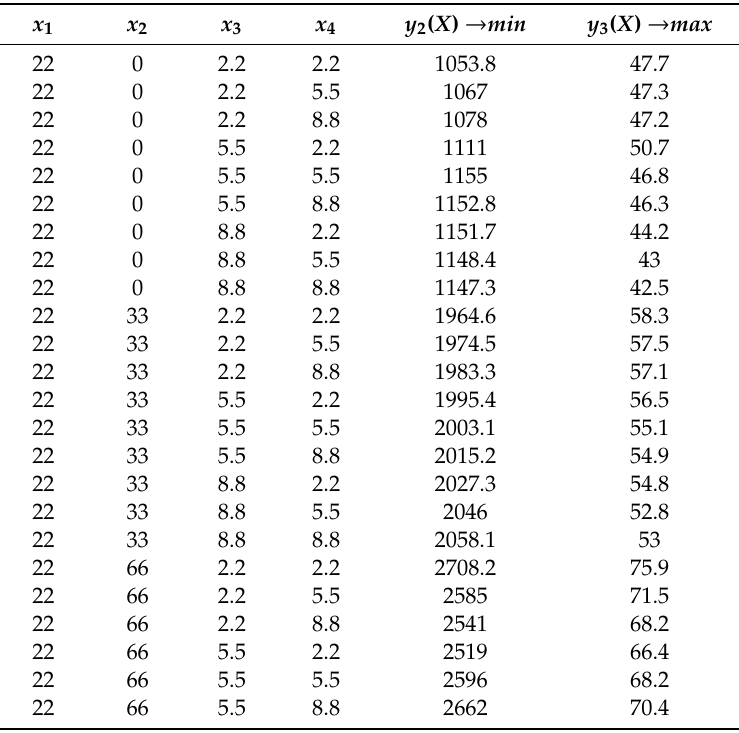
Table 7. Numerical values of parameters and characteristics of the